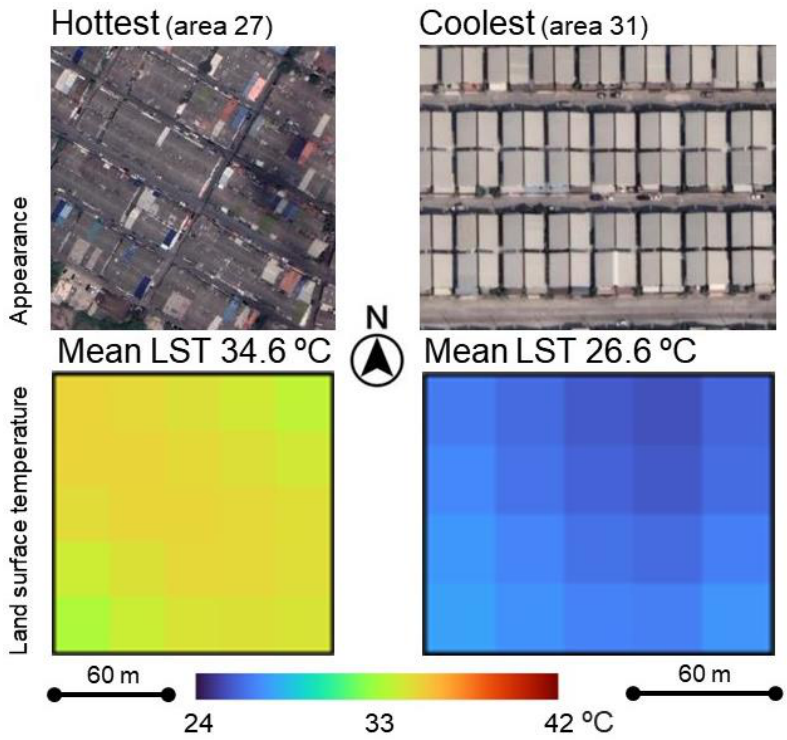
Figure 4. Appearance of the hottest and coolest of the 62 residential areas (top) and land surface temperature (bottom). The true-color images (top) were acquired in 2021